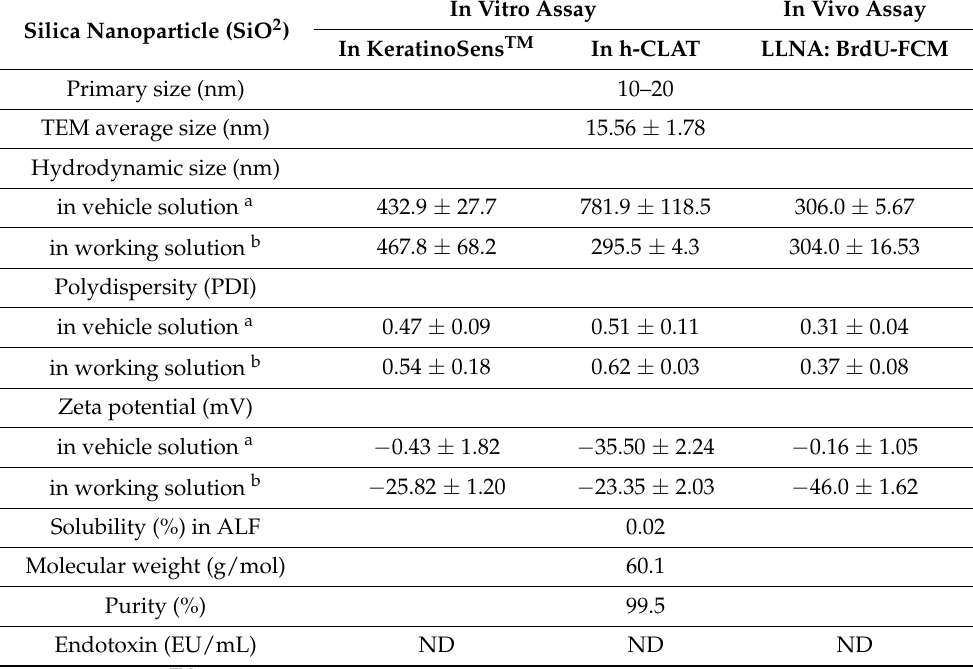
Table 1. Physicochemical properties of silica NP.